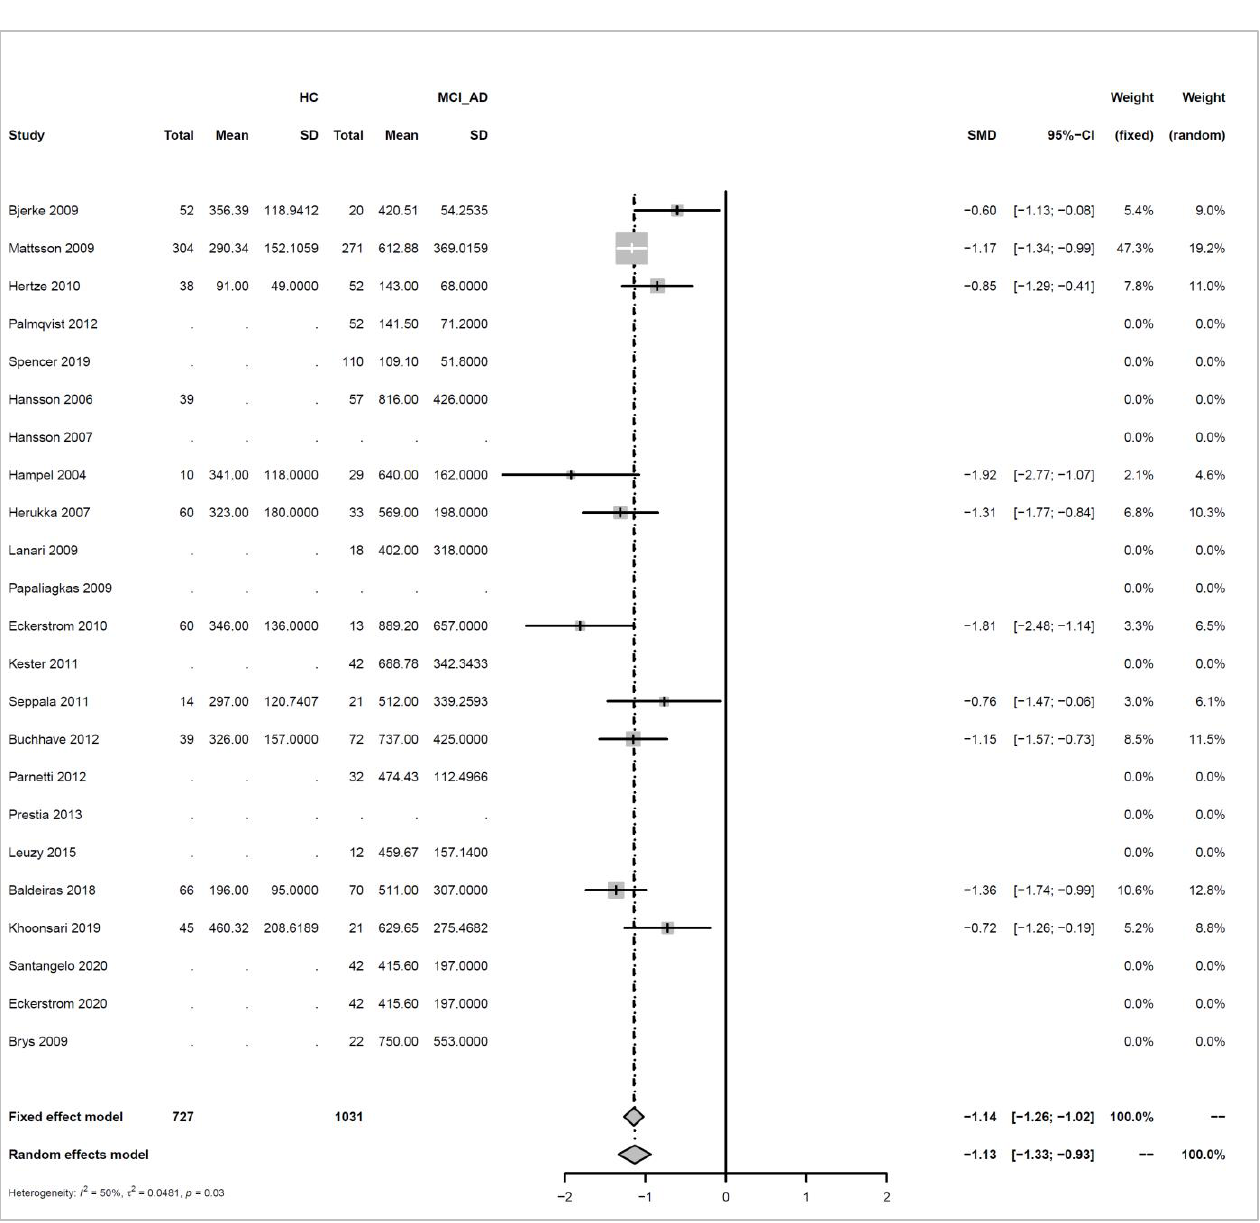
Figure 10. Meta analysis of studies investigating CSF T-tau levels for healthy control (HC) versus progressive MCI (MCI_AD), see Appendix A.3.2 [30,32,34 – 37,44 – 50,52 – 55,57,58].